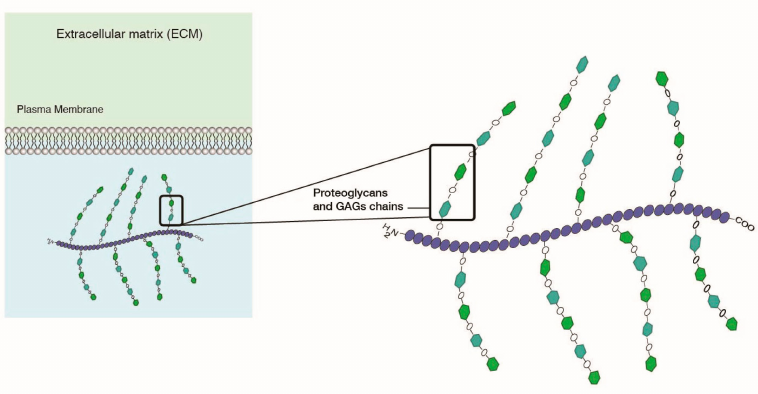
Figure 11. Extracellular matrix has a negative charge due to presence of proteoglycans and